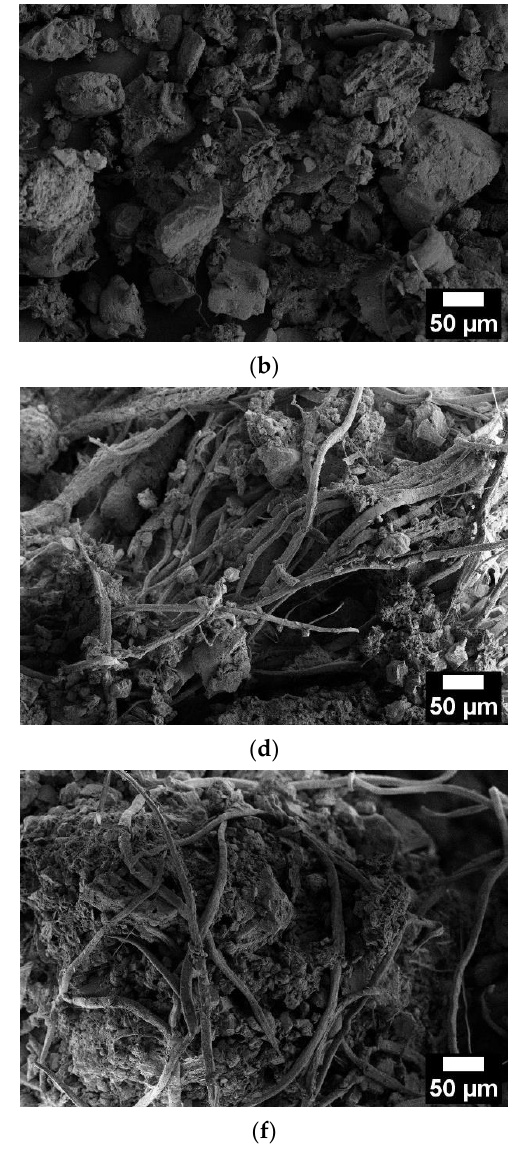
Figure 6. SEM micrographs of the ( a ) neat soil and soil mixed with ( b ) X1, ( c ) X1W2, ( d ) X1W5, ( e ) X4W2, and ( f ) X4W5 hydrogels.